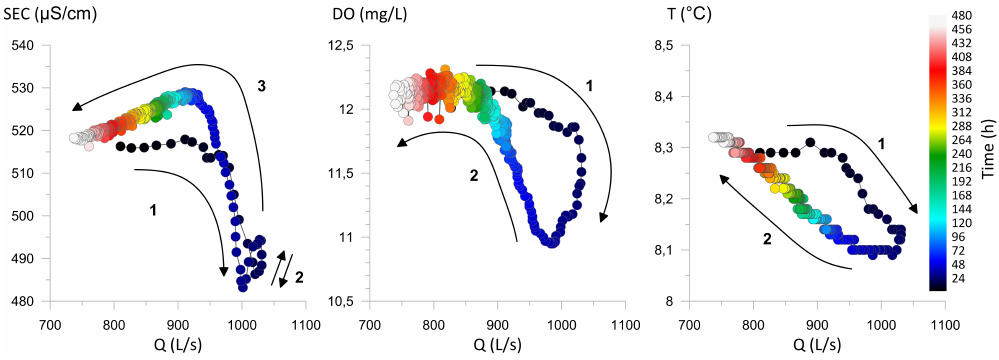
Figure 8. Hysteresis curves of specific conductivity (SEC), dissolved oxygen (DO), and temperature (T) vs. discharge (Q) during maximum recorded flood event in March–April 2018 (Figure 7). Numbers indicate succession of di ff erent phases in dynamics (note that phases are not synchronous and analogous among di ff erent parameters: SEC dynamics is separated into three, while DO and T into two